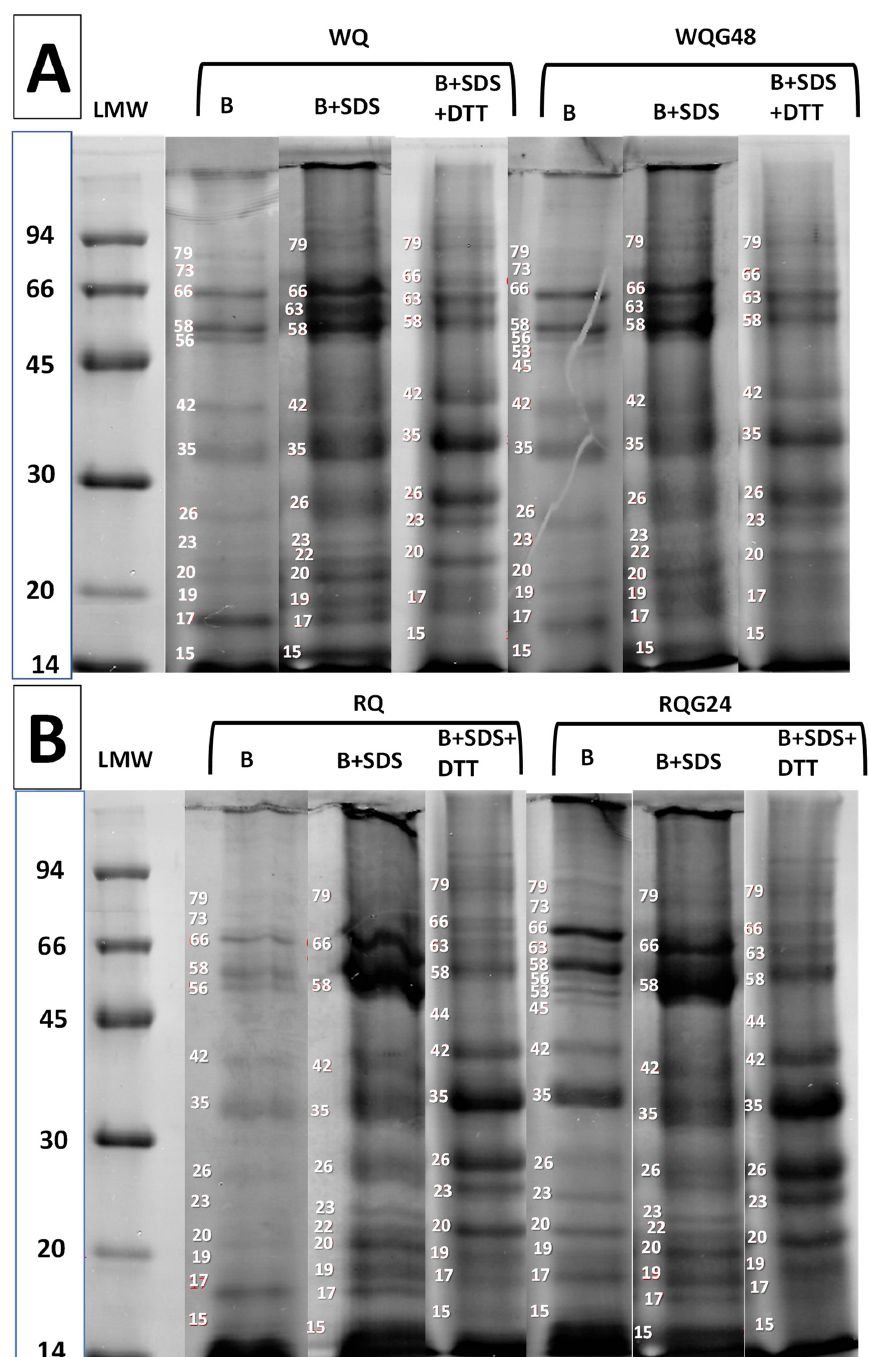
Figure 2. SDS ‐ PAGE of proteins from quinoa flours: WQ: white quinoa, and WQG48: germinated 48 h ( A ). RQ: red quinoa, and RQG24: germinated 24 h ( B ). Protein extracted in buffer pH = 8 ( B ), buffer pH = 8 with 2% w / v SDS (B + SDS) and buffer pH = 8 with 2% w / v SDS and 0.5% w / v DTT (B + SDS + DTT).